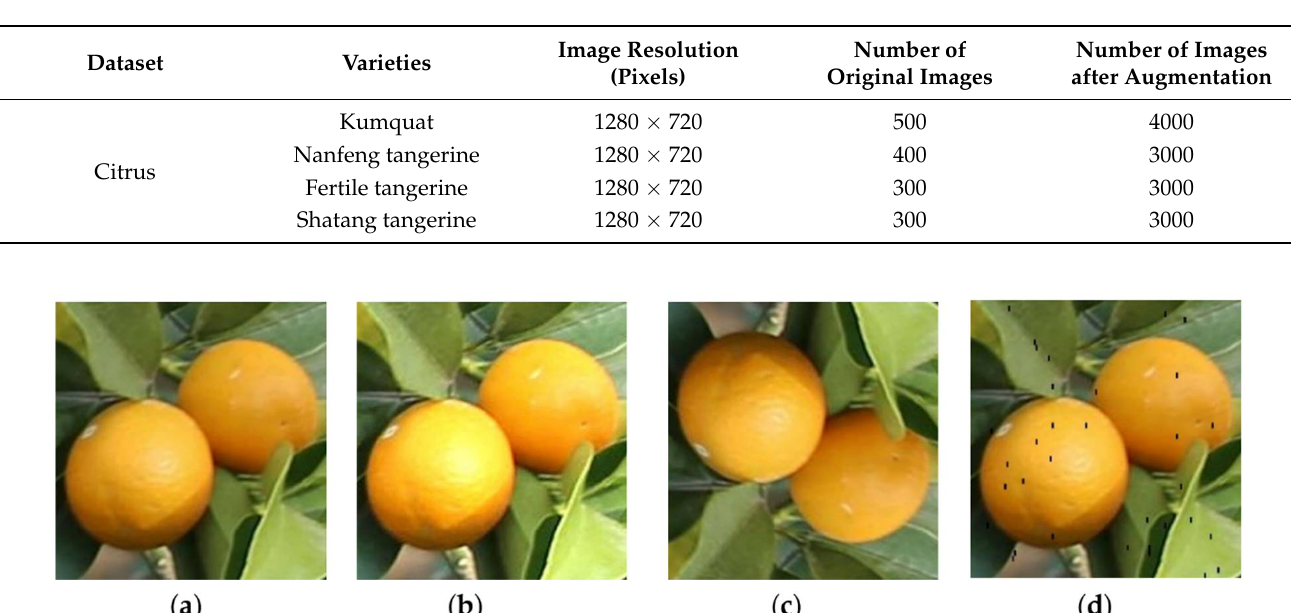
Figure 1. The RGB images of the four varieties of citrus: ( a ) Kumquat; ( b ) Shatang tangerine; ( c ) Fertile orange; ( d ) Nanfeng tangerine.